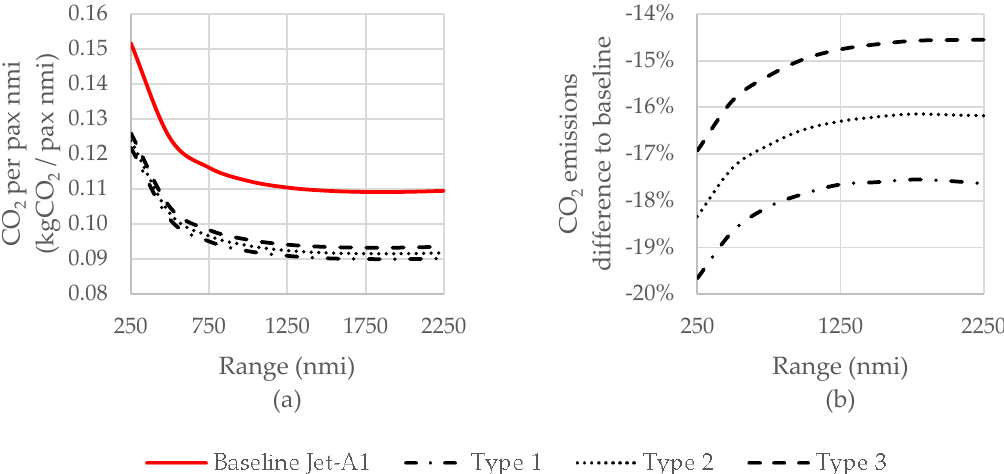
Figure 13. ( a ) kg of CO 2 emissions per pax nmi against range and ( b ) the corresponding difference from the baseline.